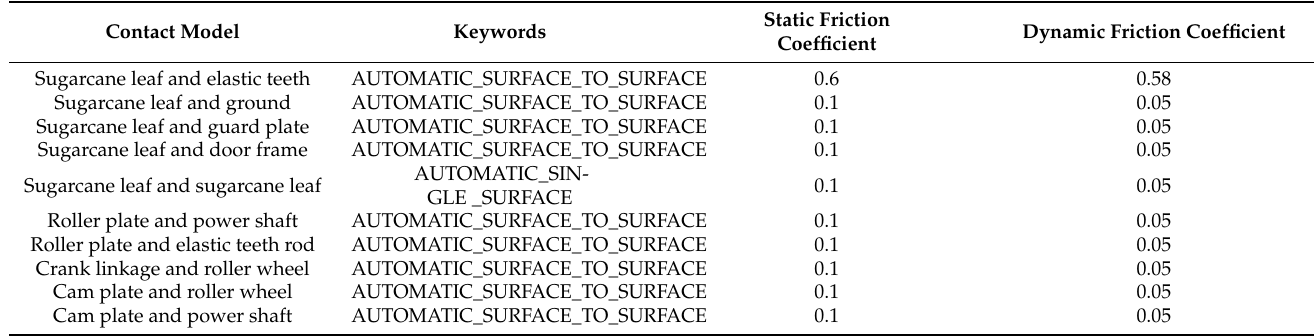
Table 3. Contact settings.